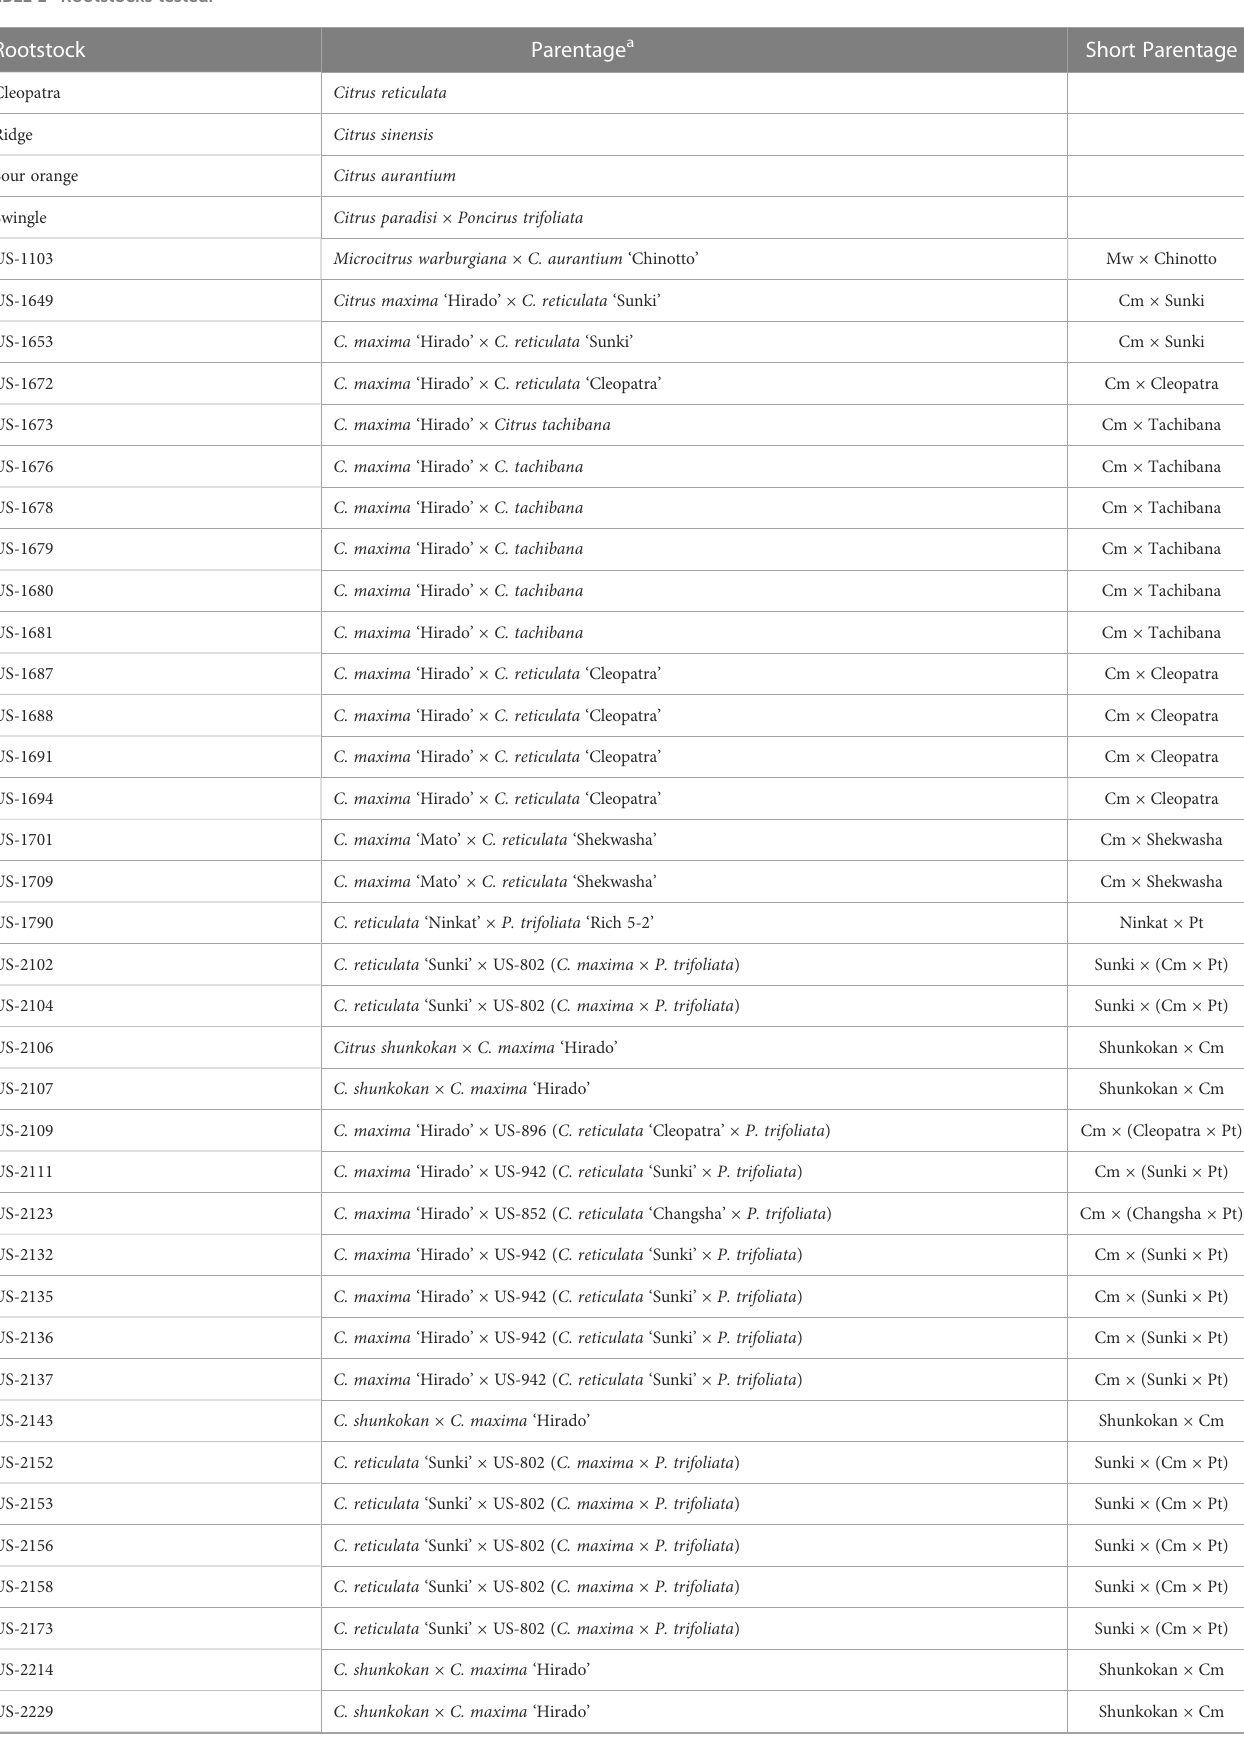
TABLE 1 Rootstocks